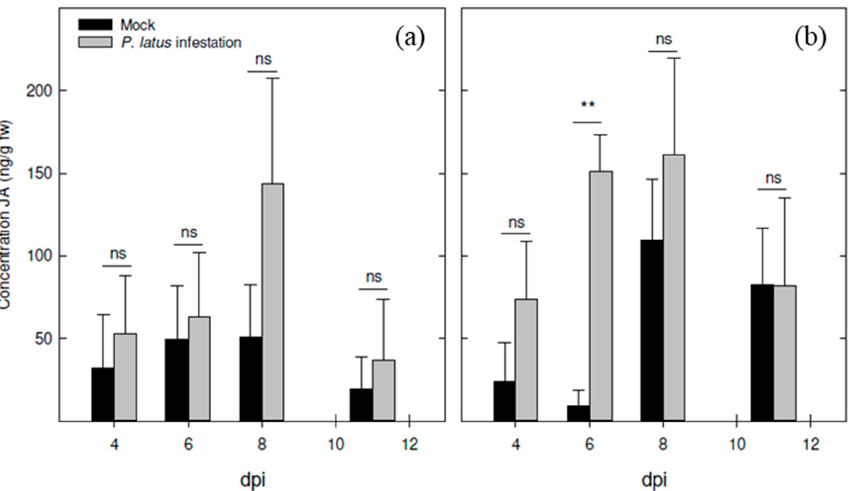
Figure 1. Levels of jasmonic acid (JA) in experiment 1 analyzed 4, 6, 8 and 11 days post-infestation (dpi) in the pot azalea cultivars ‘Nordlicht’ ( a ) and ‘Elien’ ( b ). Treatments are mock or Polyphagotarsonemus latus -infested leaflets and presented as the average (+SE) ( n = 5). Significant differences compared to the respective mock are marked: ns = not significant; ** p < 0.01 (Mann–Whitney U).